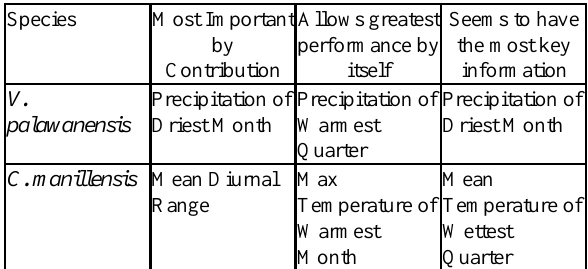
Table 3. Important aspects of climate that affects V. palawanensis and C.